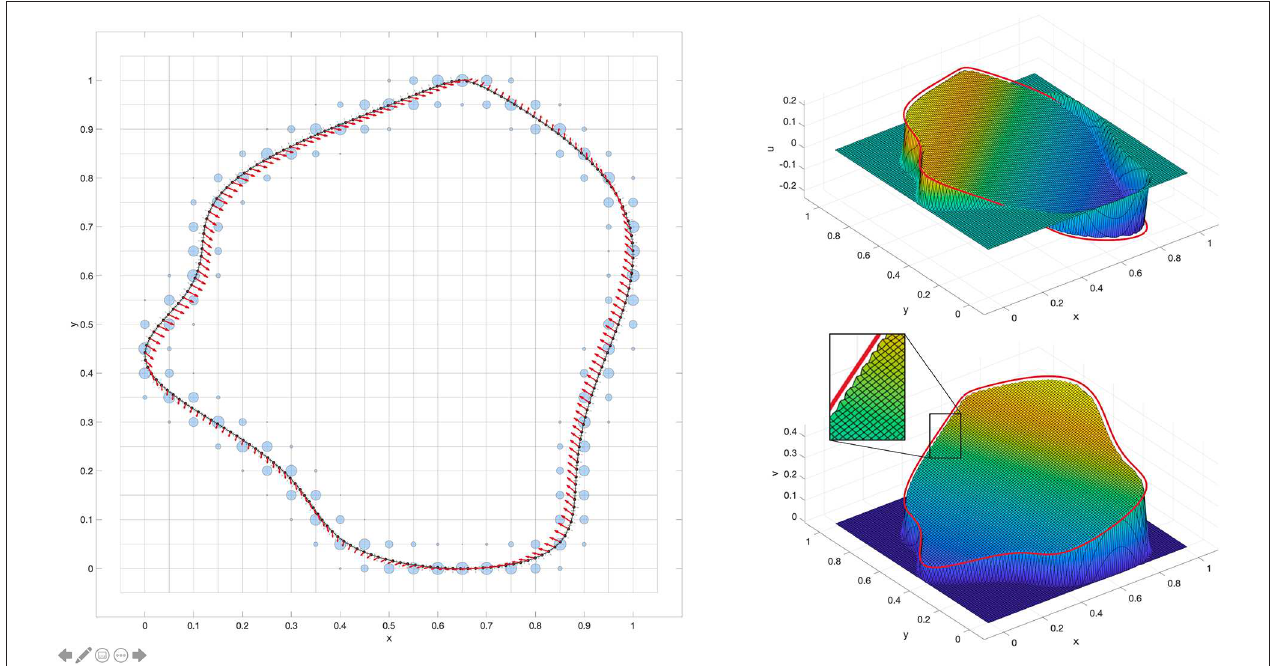
FIGURE 2 | Raw results for the displacements of an arbitrary shape. The shape is cut out of a rectangular body (see left graph in Figure 1 ) with uniformly distributed loads σ A = − 0.8, σ B = 0.1, and σ C = 0.7. For the elastic parameters it was chosen ν = 0.3 and µ = 1. The stress distribution on the boundary of the shape is shown with the red arrows in the left image. The blue circles show the weights which result from the Lagrange polynomials used for the bilinear interpolations necessary for the convolution (for details see the main text of this section). The colored images on the right show the raw results for the displacements u and v obtained with the convolution. The red line represents the analytical solution for the displacements on the boundary of the shape. Note that the resolution of both the boundary and the FFT grid is chosen lower in the image on the left than in the results on the right merely for the purpose of a better visualization.